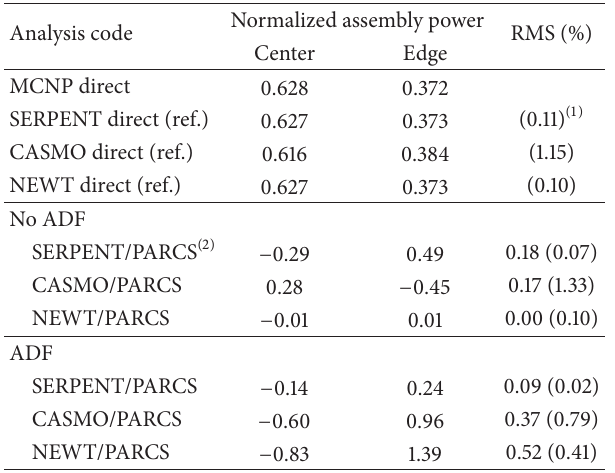
Table 10: The assembly power distribution by a direct and two-step modeling for DIMPLE